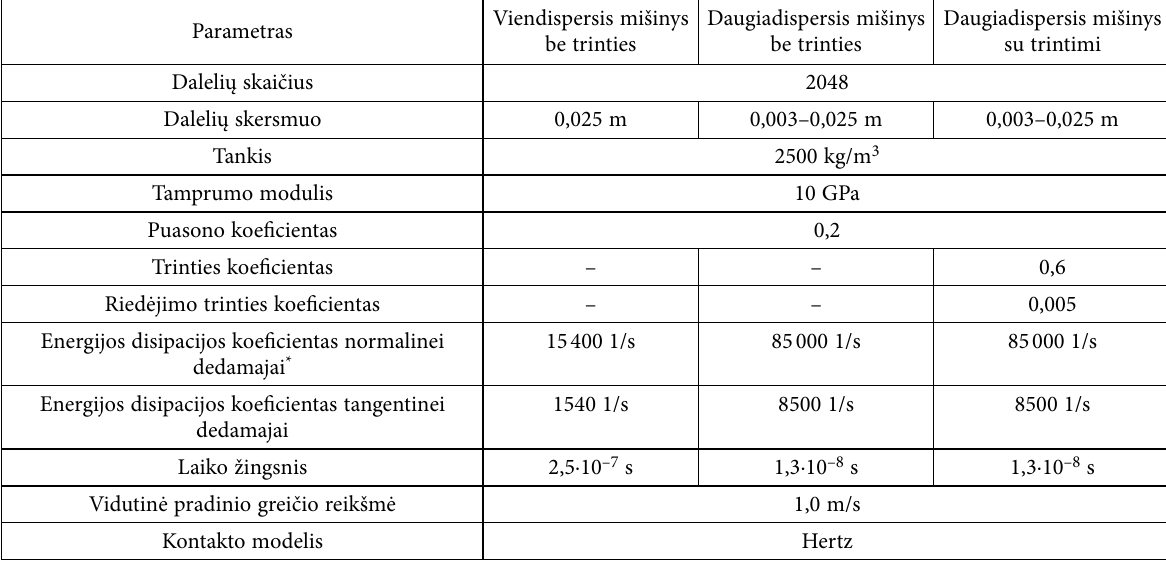
1 lentelė. Dalelių modeliavimo charakteristikos Table 1. Characteristics of modelling particles